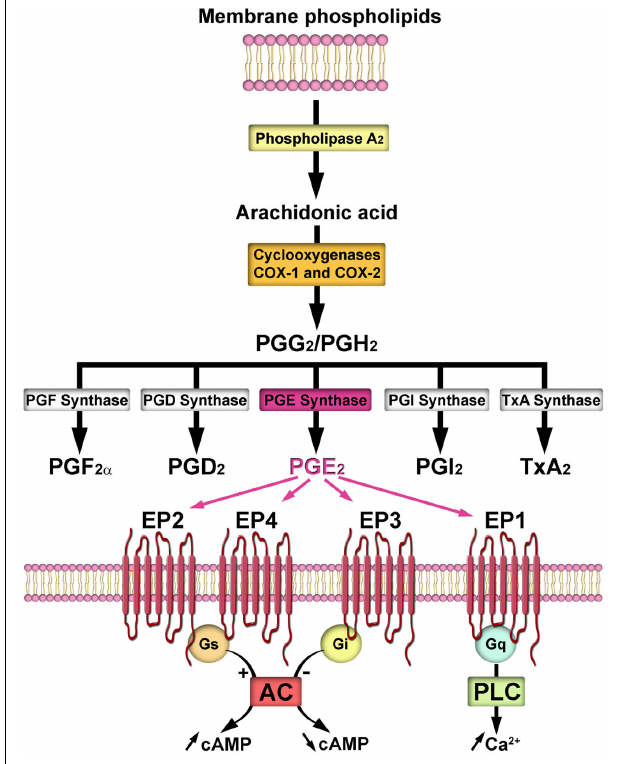
FIGURE 1 | Prostaglandin E 2 (PGE 2 ) biosynthesis and signaling. Upon its release from plasma membrane phospholipids by phospholipase A 2 , arachidonic acid is converted to the unstable endoperoxide intermediates, prostaglandin G 2 (PGG 2 ), and prostaglandin H 2 (PGH 2 ) by the cyclooxygenases (COX-1 and COX-2, encoded by separate genes). Both COX isoforms catalyze the same reactions, but while COX-1 is constitutively expressed, COX-2 is rapidly and transiently upregulated by cytokines and growth factors.Terminal synthases convert both PGG 2 and PGH 2 into prostaglandins [PGE 2 , PGD 2 , PGF 2 α , prostacyclin (PGI 2 )], and thromboxane (TxA 2 ). Once synthesized, PGE 2 immediately diffuses away and activates its specific E-prostanoid receptors (EP1–4), which belong to the family of seven-transmembrane G-protein-coupled receptors. EP2 and EP4 are coupled to Gs and stimulate the adenylyl cyclase (AC)–cyclic adenosine monophosphate (cAMP)–protein kinase A (PKA) pathway. In contrast, EP3 is coupled to Gi and inhibits AC activation, resulting in decreased cAMP concentrations. EP1 is thought to be coupled to the Gq-phospholipase C (PLC) pathway, leading to an elevation of free cytosolic calcium concentrations (Milatovic et al., 2011). Notably, an examination of the capacity of the hypothalamus to metabolize arachidonic acid through the COX pathway has revealed a pubertal increase in the formation of PGE 2 , particularly during the first proestrus (Ojeda and Campbell, 1982). Intriguingly, the increase in PGE 2 synthesis is not associated with changes in the formation of PGF 2 α , PGI 2 , PGD 2 , or thromboxane A 2 from exogenous arachidonic acid, suggesting that it is a specific event directly associated with the peripubertal activation of the reproductive hypothalamus (Ojeda and Campbell, 1982). Such a selective synthesis of PGE 2 has also been shown to be triggered by estrogens during early postnatal development (Amateau and McCarthy, 2002).